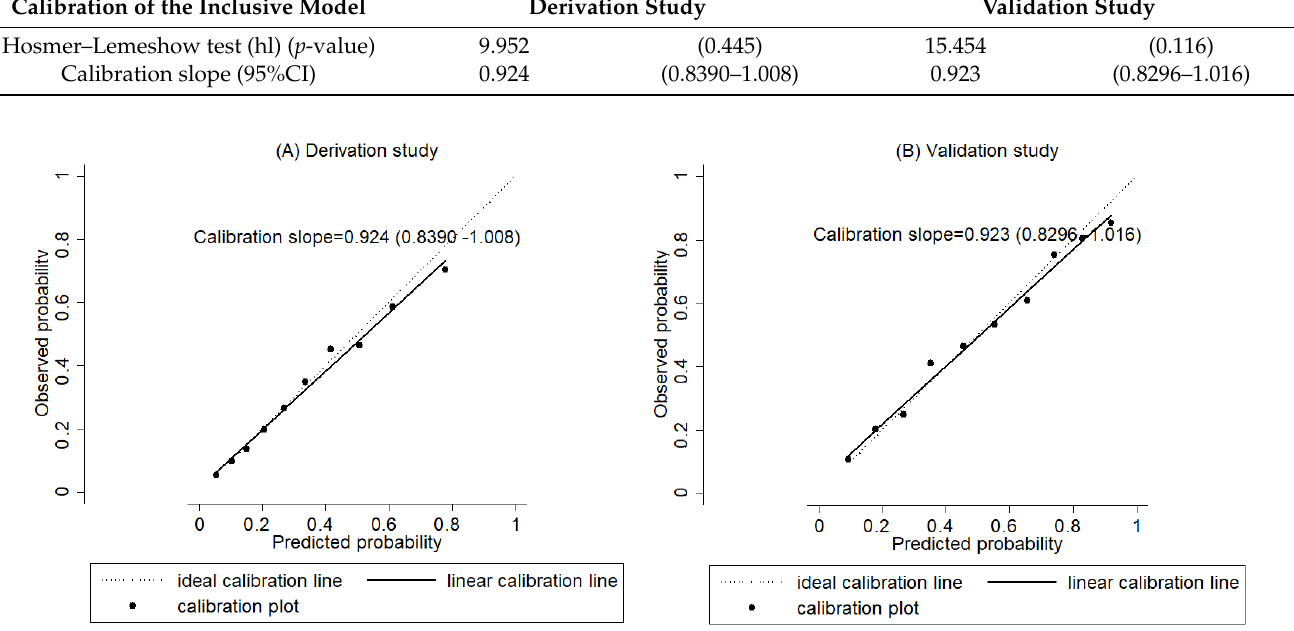
Figure 2. Calibration slope in the derivation ( A ) and validation ( B ) study (inclusive model). The calibration plots of the inclusive model stayed close to the ideal calibration line throughout the risk spectrum in all data sets of both studies, and calibration slopes were close to 1.0.